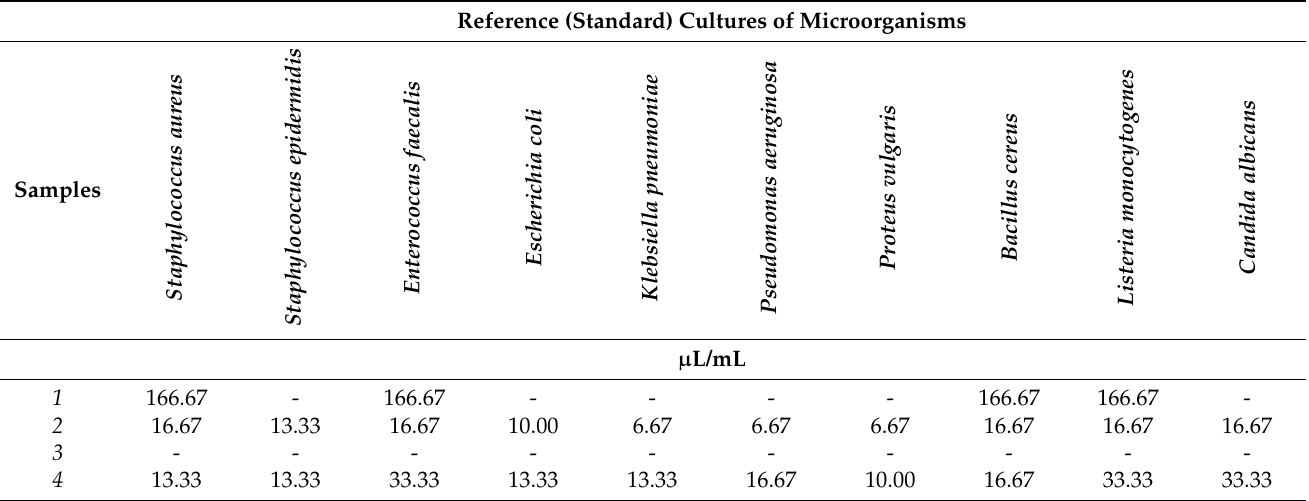
Table 4. Minimal inhibitory concentrations against pathogenic bacteria. Reference (Standard) Cultures of